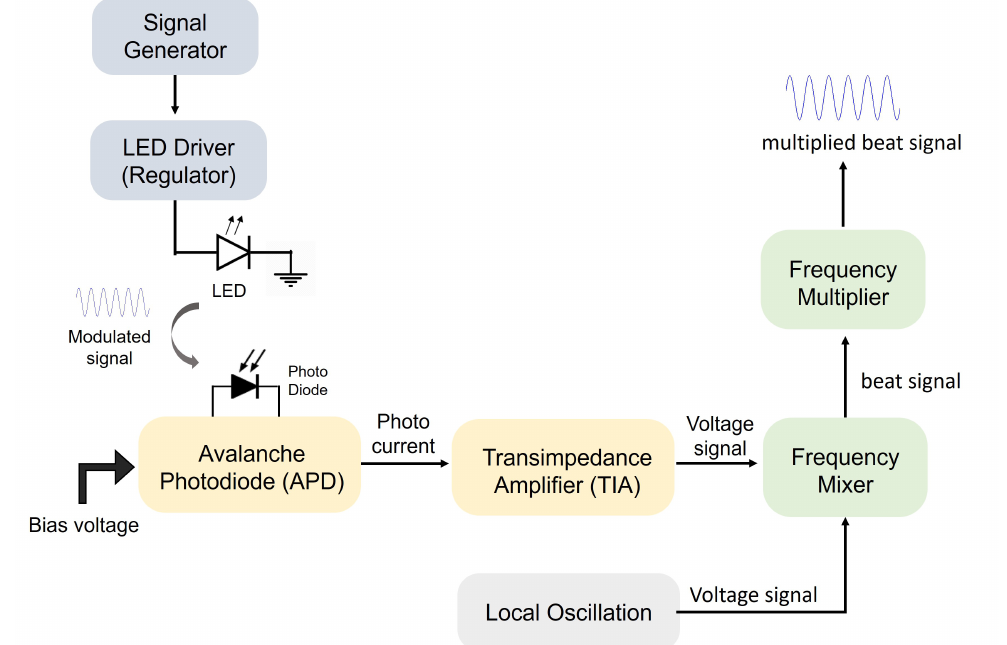
Figure 5. Diagram of the system setup for frequency shift